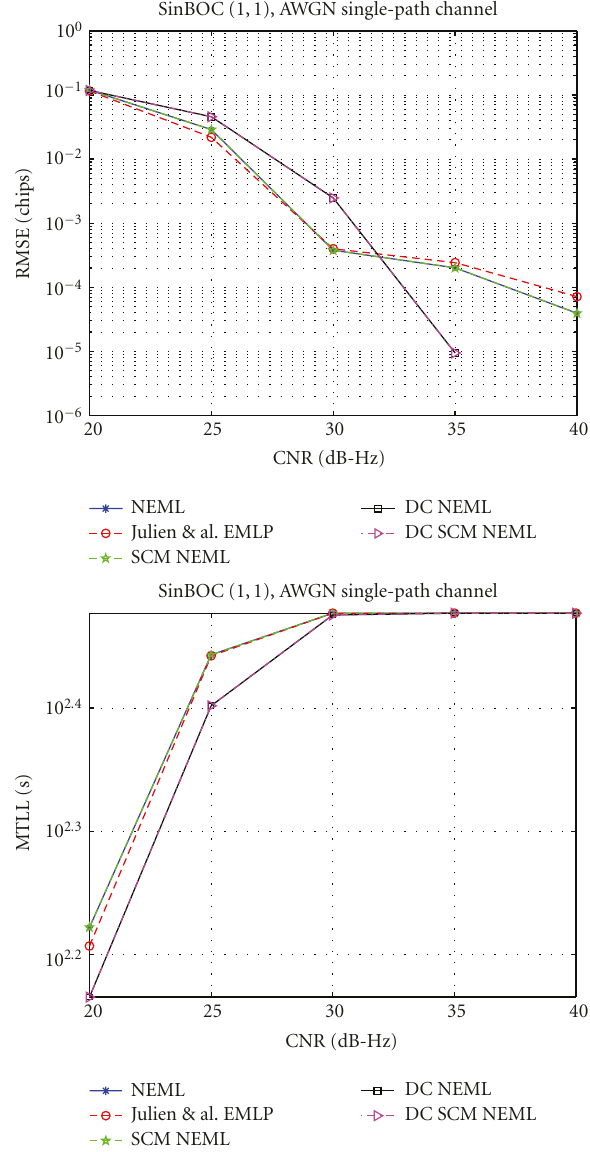
Figure 16: Comparison of feedback delays estimation algorithms employing the NEML discriminator and of the Julien&al. method, as a function of CNR; upper plots: RMSE, lower plots: MTLL. NEML and SCM NEML curves are overlapping. DC NEML and DC SCM NEML curves are also overlapping (di ff erences at the 3rd dec-